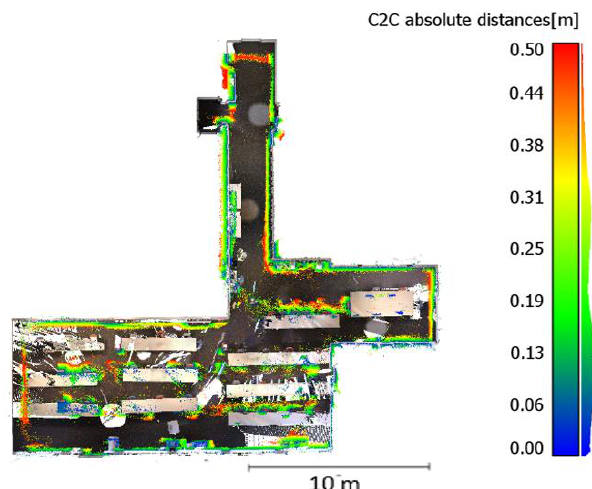
Figure 11 . Top view of the TLS point cloud map (the ceiling points are not shown in order to show the interior structure) and Kiwi point cloud (coloured based on point distance to the TLS map) for the FOI